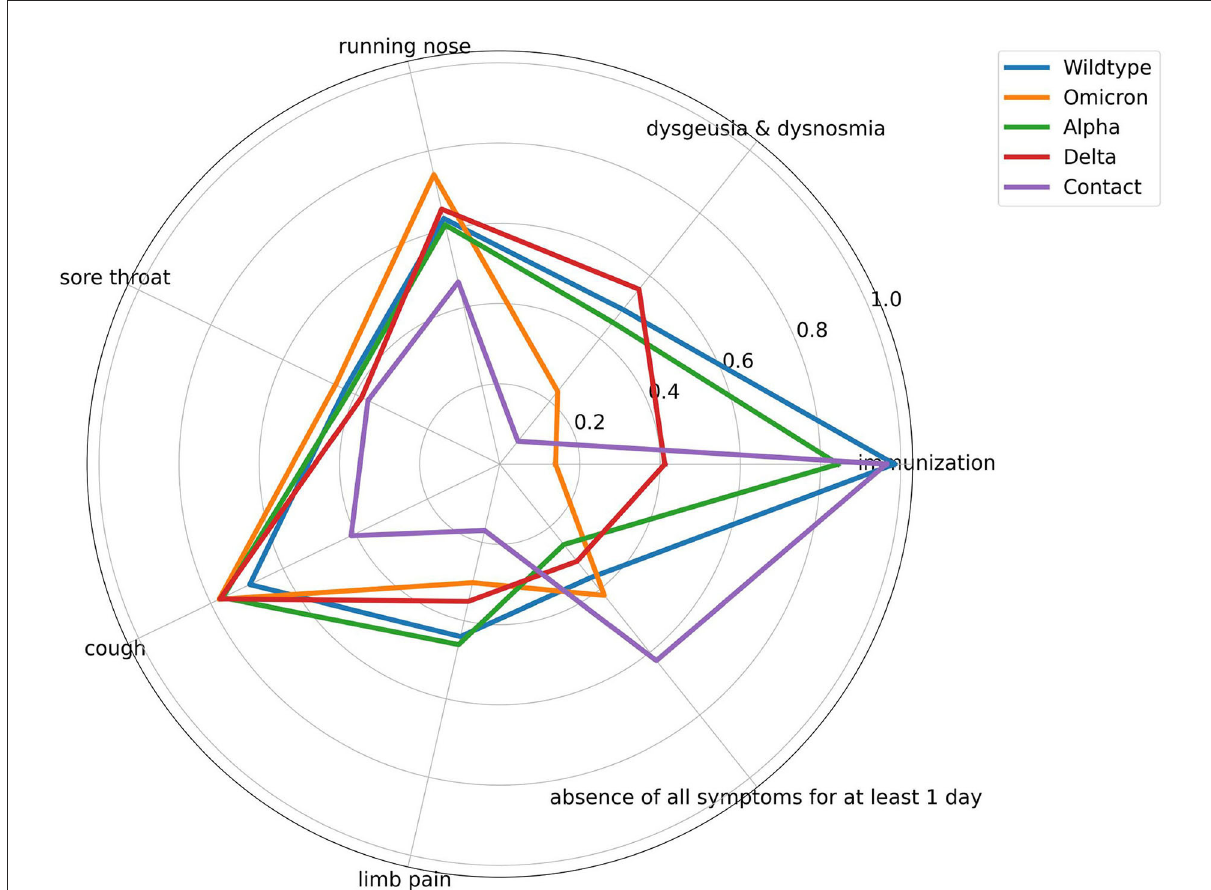
FIGURE3 Spider plot of averaged symptom profile for the different prevailing dominant virus variants and contact persons. All symptoms range from [0,1] with 0 means symptom does not occur and 1 means symptom occurs. Immunization ranges from [0, 1], with 1 means no vaccination, and 0 means any type of vaccination regardless of the